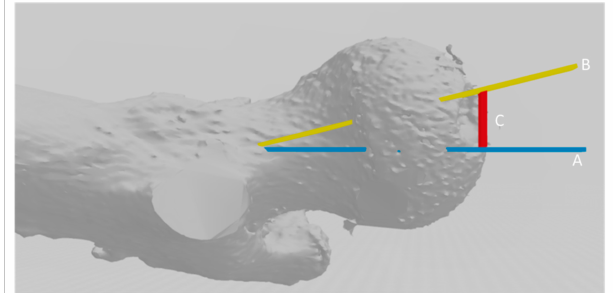
Figure 2. Extrapolation of the error in millimeters calculated with the Hausdor ff -Besicovitch method in degrees of femoral anteversion using Murphy’s method [15]. Line C, in red, represents the magnitude of the error. Line B represents the femoral neck, whose value can be calculated. After calculating the length of the femoral neck, it acts as a hypotenuse of a right-angled triangle whose right angle is represented between lines C and A. Therefore, the sine of angle B–A is obtained by dividing the value of length C / length B, whose data are known. Therefore, it converts the error in millimeters into angles of error to be able to test the hypothesis with the degrees of errors produced, taking the population mean as a